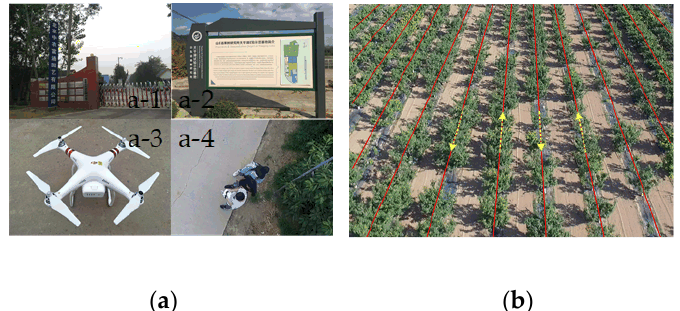
Figure 2. Image acquisition: ( a ) a-1: cherry orchard at Zhongnong Futong; a-2: apple orchard in Taian; a-3: photographing device; a-4: data collection team. ( b ) the Unmanned Aerial Vehicle (UAV) flight route